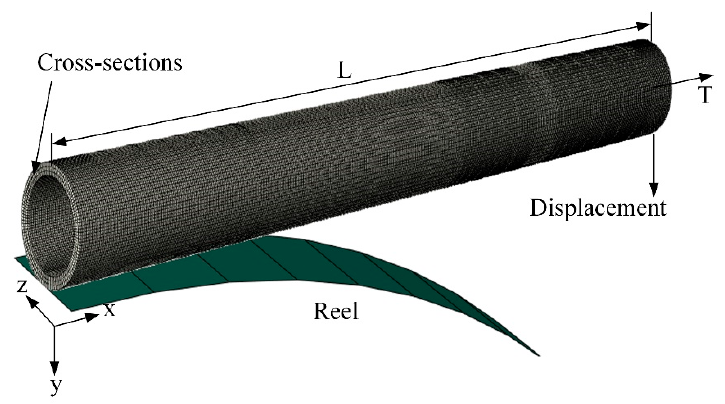
Figure 7. Finite element mesh of pipe and reel.